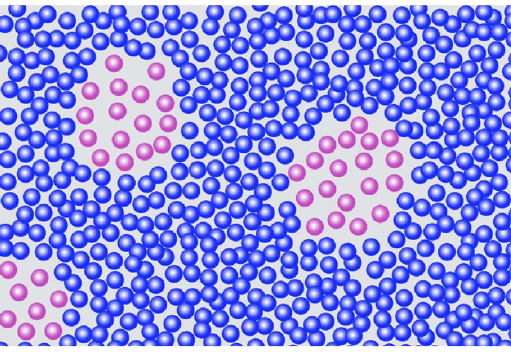
Figure 11. Flow unit model. 123